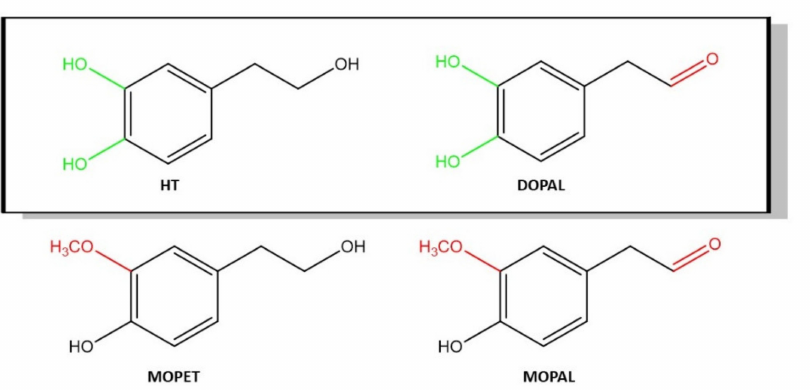
Figure 4. Chemical characteristics of HT and its metabolites which seem to drive VEGF inhibition (green) and non-effect